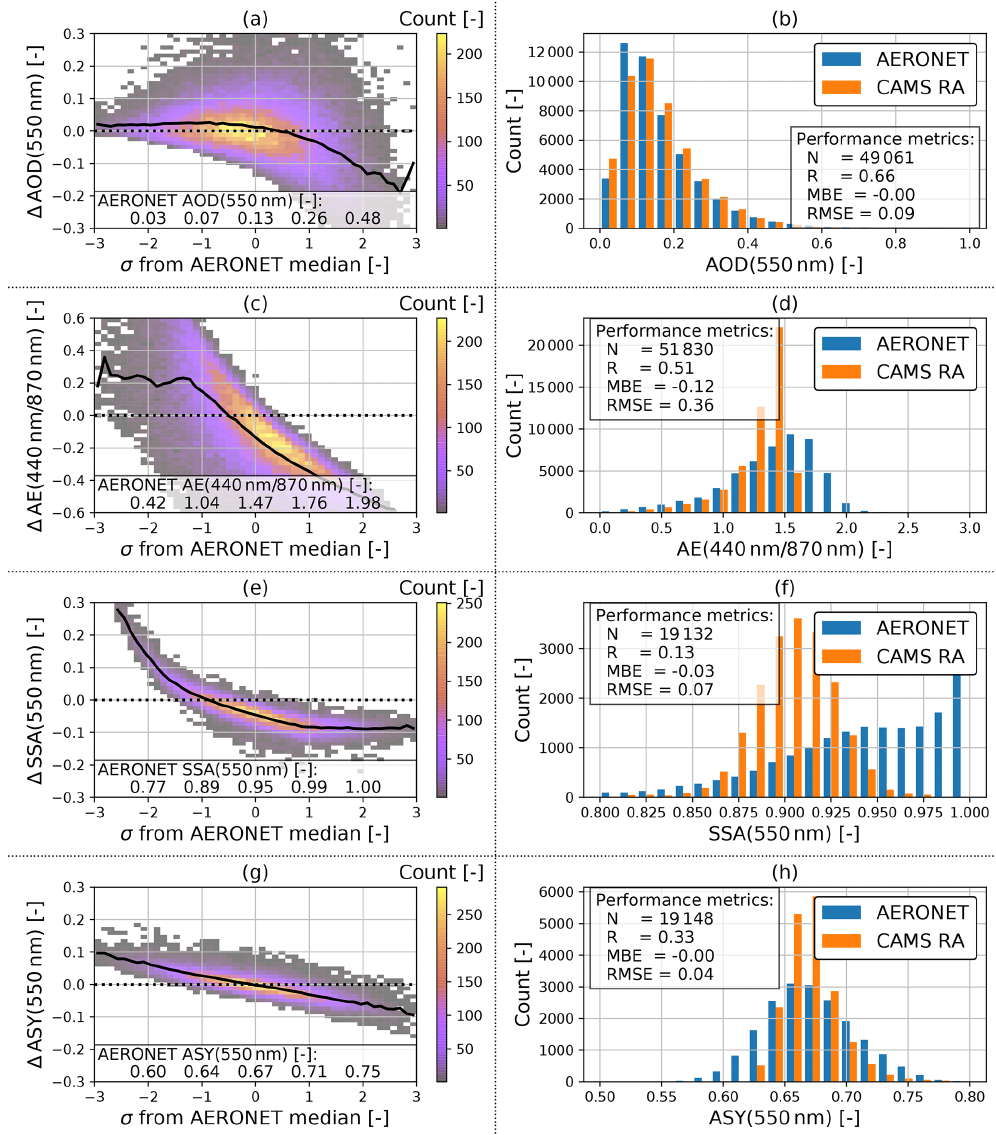
Figure 3. Evaluation of the CAMS RA aerosol properties database versus AERONET aerosol products in Germany in the period from 2003 to 2019. Left panels show the deviation of a quantity (CAMS RA – AERONET) on the left y axis as a 2D histogram and the mean as a black line. The values on the left panels are plotted versus quantiles (number of standard deviations σ from median) of the AERONET distribution. The right panels show the dataset distribution of each quantity and calculated evaluation